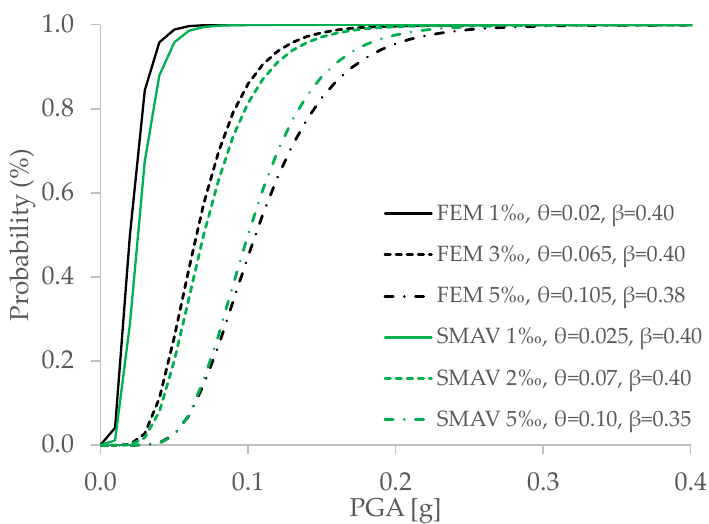
Figure 11. Fragility curves ASI comparison between FEM model and SMAV model.